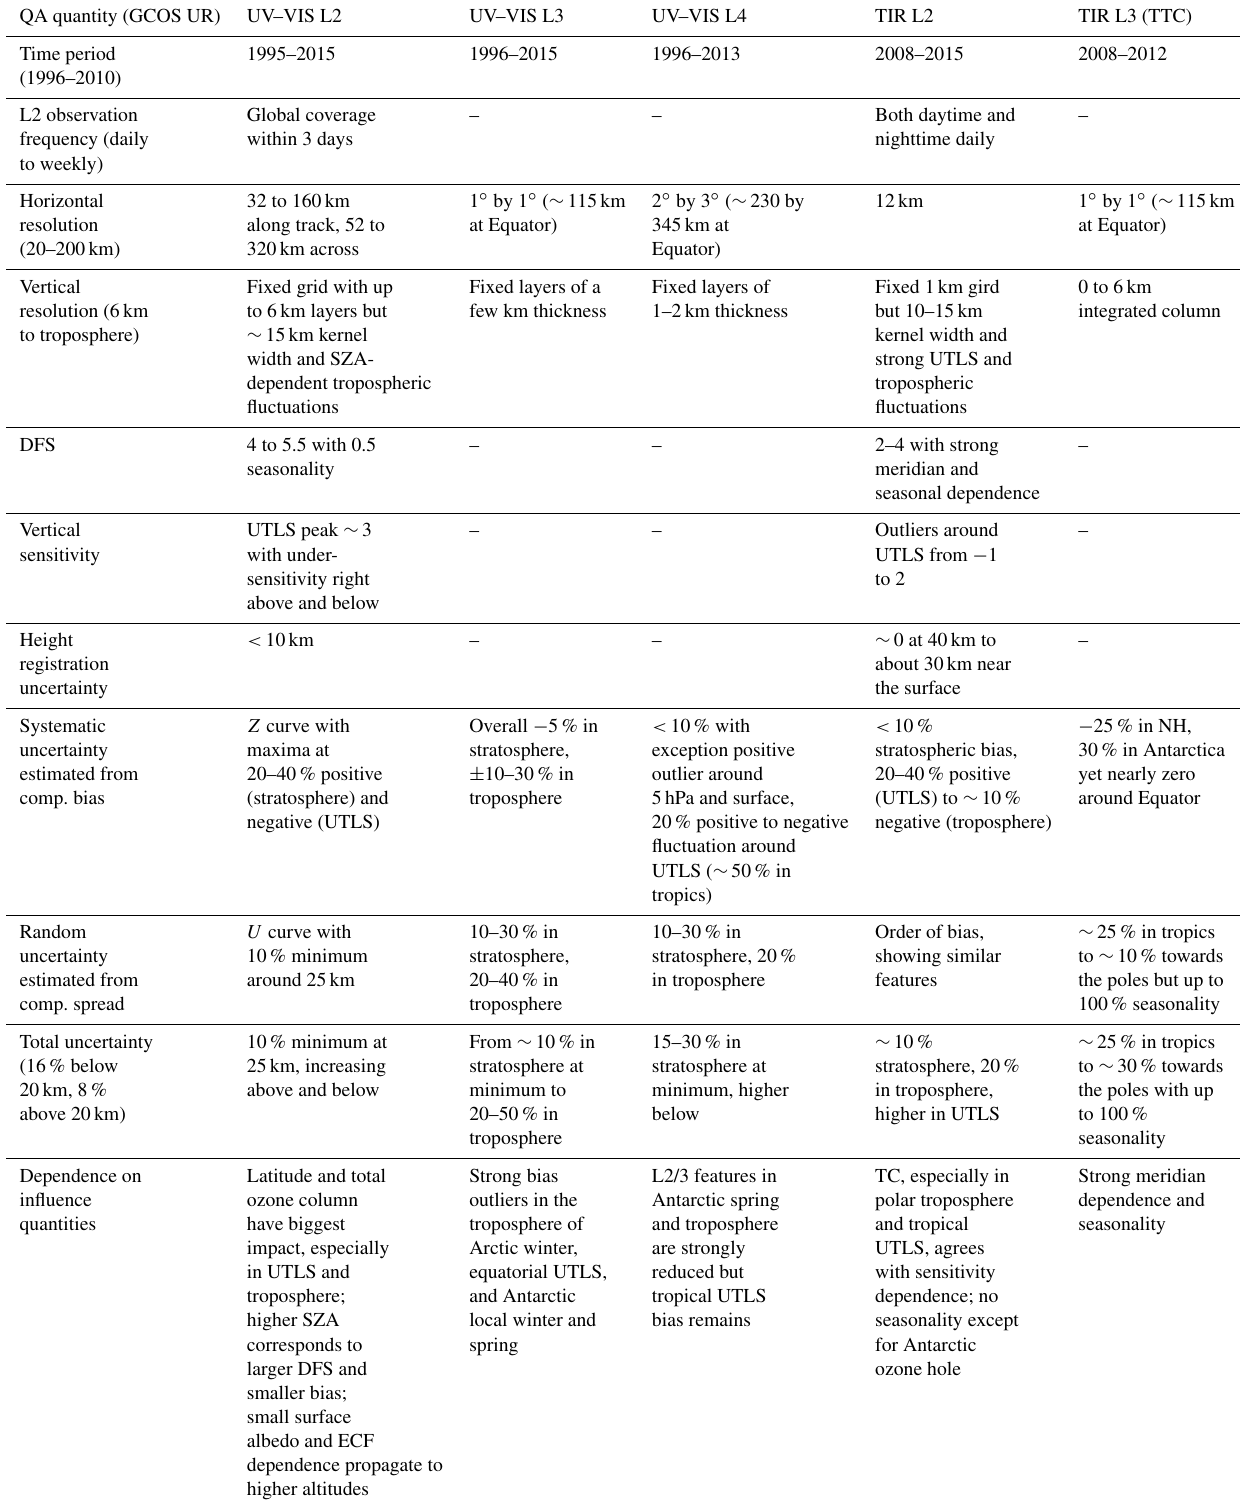
Table 5. Major QA and validation quantities, their corresponding typical values, and indication of GCOS user requirement (UR) compliance for the Ozone_cci nadir ozone profile